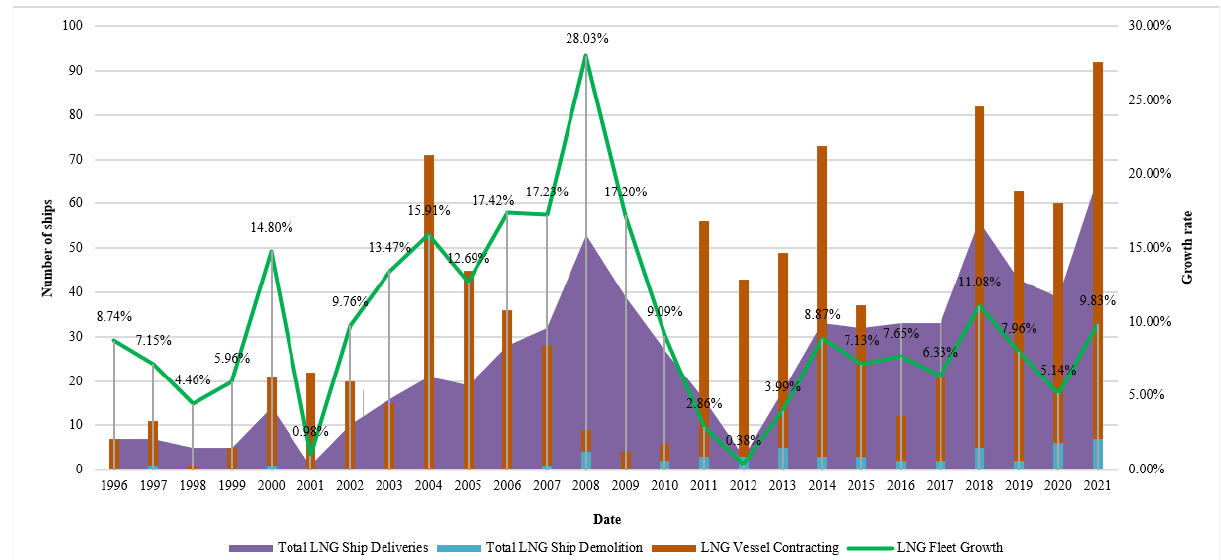
Figure 1. Number of LNG ships delivered, scrapped, and in new building from 2011 to 2021.